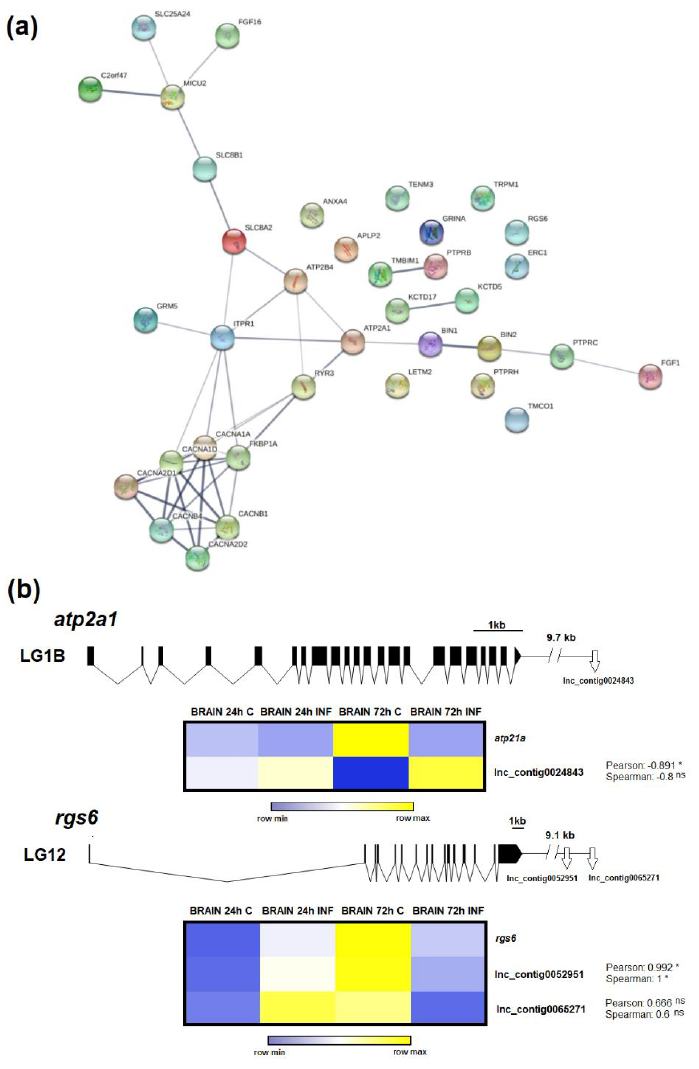
Figure 8. Calcium homeostasis-related genes and their relationship with lncRNAs. ( a ) Protein–protein interaction network of the lncRNAs neighbouring coding genes involved in calcium homeostasis. Numerous lncRNAs significantly modulated in the brain after nodavirus infection were flanked by genes directly related to calcium homeostasis. ( b ) Gene representation of two genes mediating cellular calcium concentration after NNV challenge and genomic location of their neighbouring lncRNAs. Heap maps represent the TPM values of the different contigs. Expression levels are represented as row-normalised values on a blue–yellow colour scale. * represents significant correlation and ns non-significant correlation.